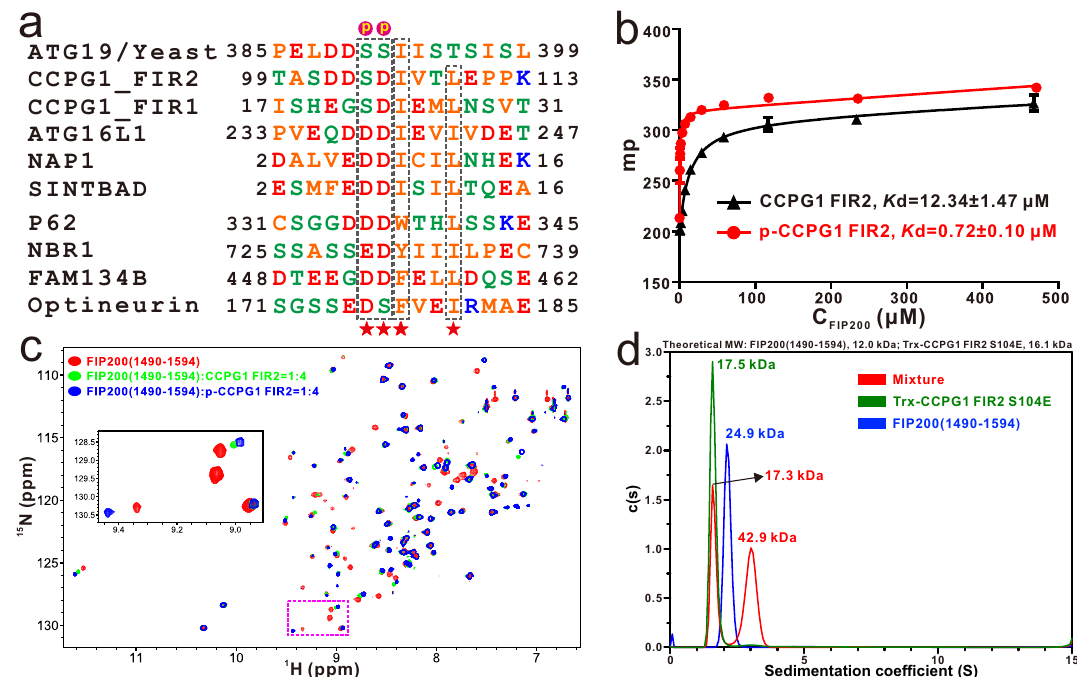
Fig. 1 Sequence and biochemical analyses of the interaction of FIP200 Claw domain with CCPG1 FIR2. a Sequence alignment analysis of the ATG11- binding motif of yeast ATG19 with the currently known FIP200 Claw-binding regions of CCPG1, ATG16L1, NAP1, and SINTBAD as well as the LIR regions of autophagy receptors, P62, NBR1, FAM134B, and Optineurin from human species. In this alignment, the highly conserved acidic residues (Asp, Glu or potentially phosphorylated Ser residue) and the following two conserved hydrophobic residues are boxed and highlighted with red stars, while the two phosphorylation sites of yeast ATG19 are further marked with “ p ” . b Fluorescence polarization (FP) based assays measure the interactions of FIP200 Claw domain (residues 1490 – 1594) with CCPG1 FIR2 (residues 99 – 113) (black) and p-CCPG1 FIR2 (residues 99 – 113) (red). In this panel, p-CCPG1 FIR2 stands for the phospho-CCPG1 FIR2 peptide (SDDpSDIVTLEPPK). The K d values are the fi tted dissociation constants with standard errors, when using the one-site binding model to fi t the FP data. Experiments were performed in triplicate and error bars represented the standard deviation here ( n = 3). Source data are provided as a Source Data fi le. c Superposition plots of the 1 H- 15 N HSQC spectra of the FIP200 Claw domain (red) and the protein titrated with CCPG1 FIR2 (green) or p-CCPG1 FIR2 (blue) at stoichiometric ratio of 1:4. For clarity, the insert shows the enlarged view of a selected region of the overlaid 1 H- 15 N HSQC spectra. d Overlay plot of the sedimentation velocity data of FIP200(1490 – 1594) (blue), the phosphomimetic CCPG1 FIR2 S104E mutant (green), and the FIP200(1490 – 1594) mixed with excess amounts of CCPG1 FIR2 S104E proteins (red). These results demonstrate that FIP200(1490 – 1594) forms a stable dimer, and can interact with the monomeric CCPG1 FIR2 S104E mutant to form a 2:2 stoichiometric complex in solution. Source data are provided as a Source Data fi